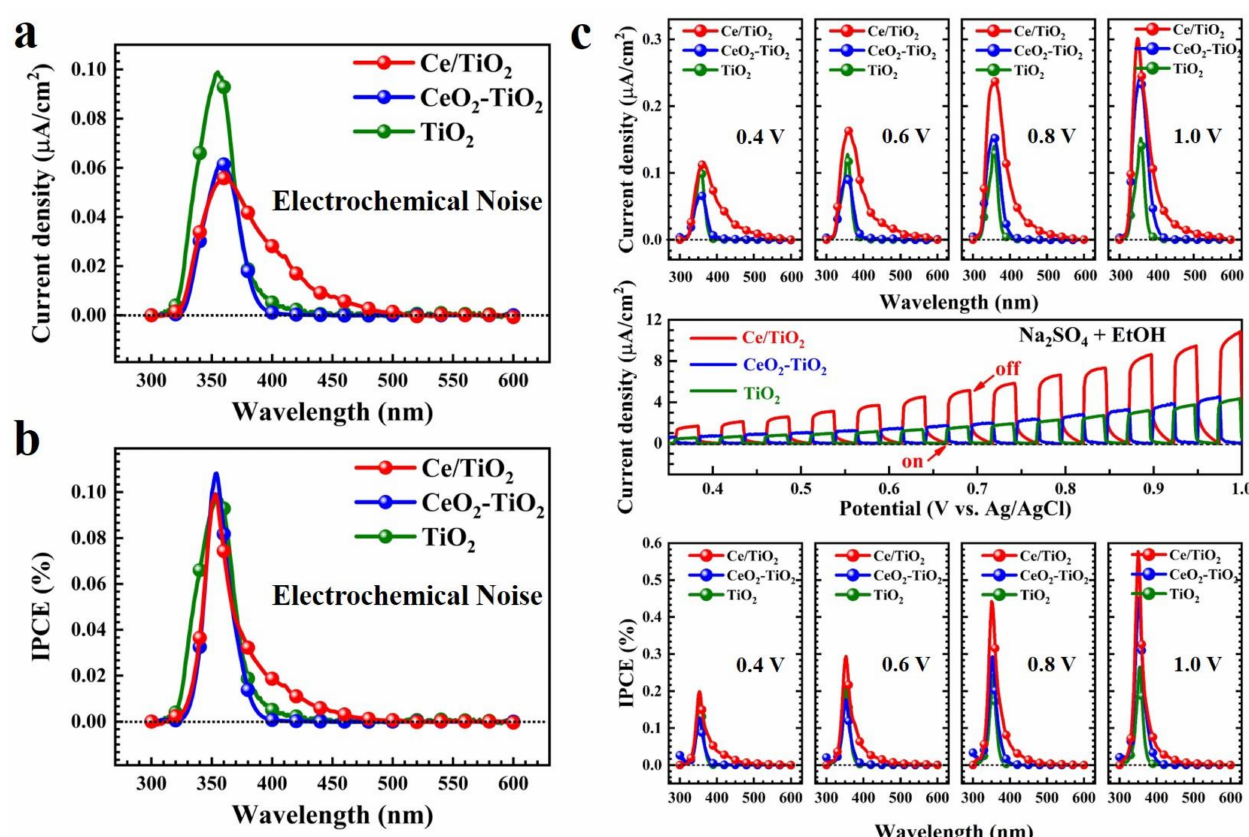
Figure 7. ( a ) Photocurrent density versus the monochromatic light in the electrochemical noise mode; ( b ) derived IPCE (%) spectra from the photocurrent density versus the monochromatic light; ( c ) photocurrent density and IPCE (%) spectra versus the monochromatic light at an increased applied voltage (V vs.